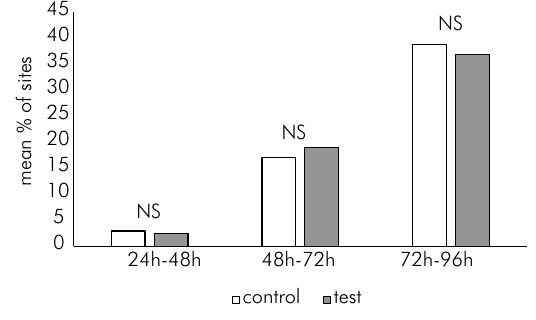
Figure 5. Percentage of conversion from scores 0 and 1 to score 2 (presence of subgingival biofilm) between time periods, for facial